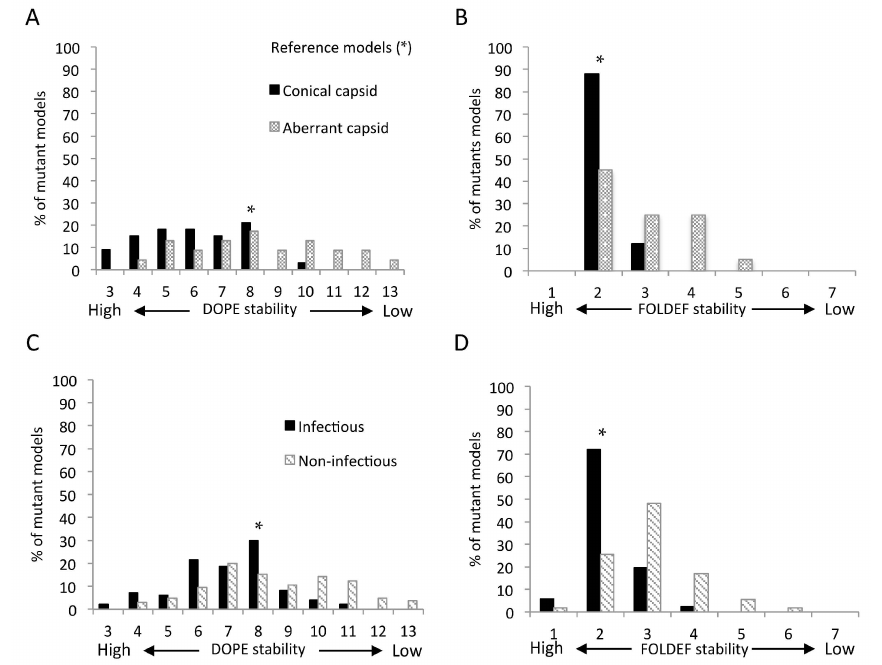
Figure 4. Predicted stabilities of mutations with known phenotypes. Flexible-backbone models were predicted by DOPE ( A , C ) and FOLDEF ( B , D ) and compared to capsid structure ( A , B ) and virus infectivity ( C , D ).